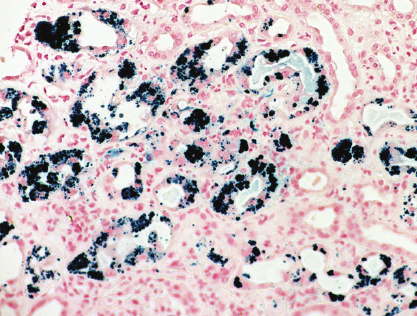
Figure 3: Prussian blue stain showing strong diffuse positivity in the tubules as coarse blue granules (Prussian blue, × 300).